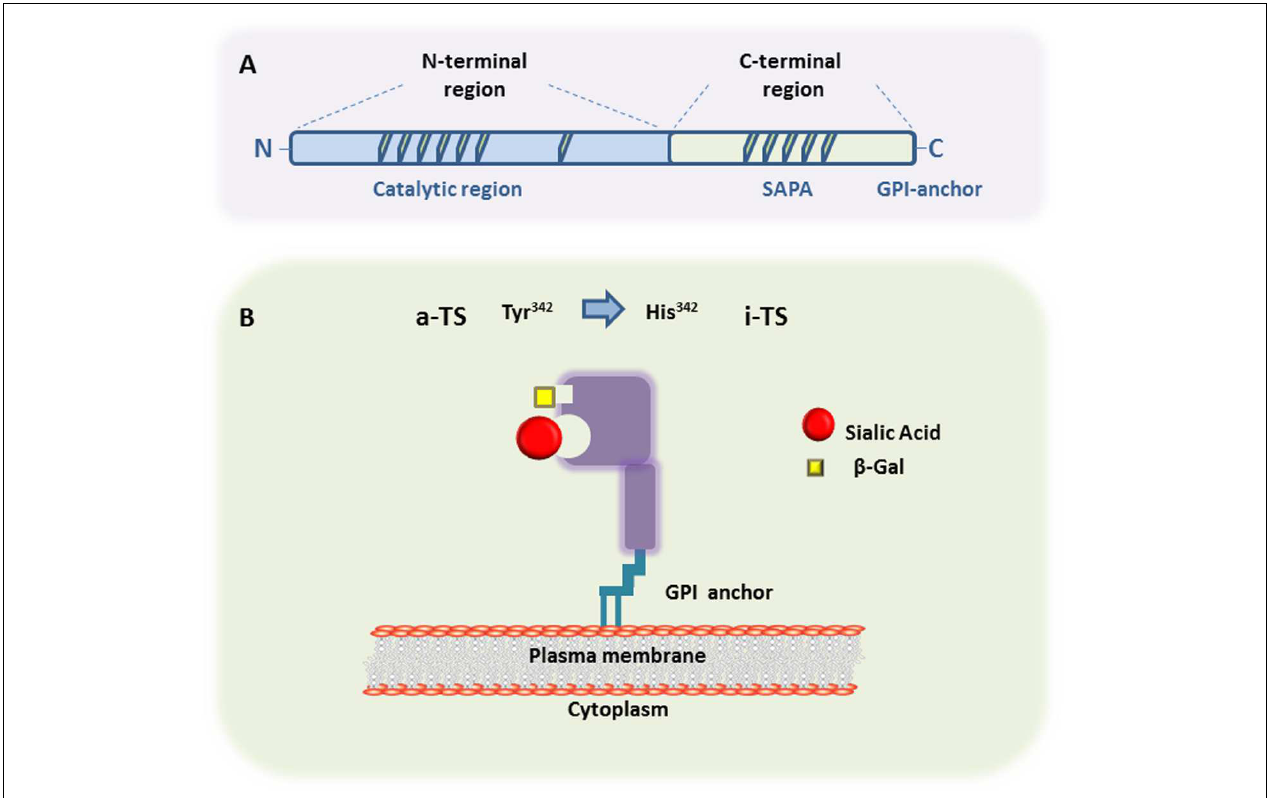
FIGURE 1 | Trans -sialidase structure. (A) Representative scheme of the primary structure of metacyclic- and a bloodstream trypomastigote-TS members belonging to either Group I (active-TS) or Group II (inactive-TS), showing the N-terminal and C-terminal domains. (B) Representative 3D structure of active (a-TS) and inactive (i-TS) forms of Trypanosoma cruzi -TS. T. cruzi- TS proteins are bound to the parasite surface through GPI-anchors. Active-TS sialylates parasite’s mucin-like molecules, as well as host cell surface glycoconjugates. Inactive-TS in turn acts as a parasite adhesin and it is differentiated from a-TS by a single mutation in